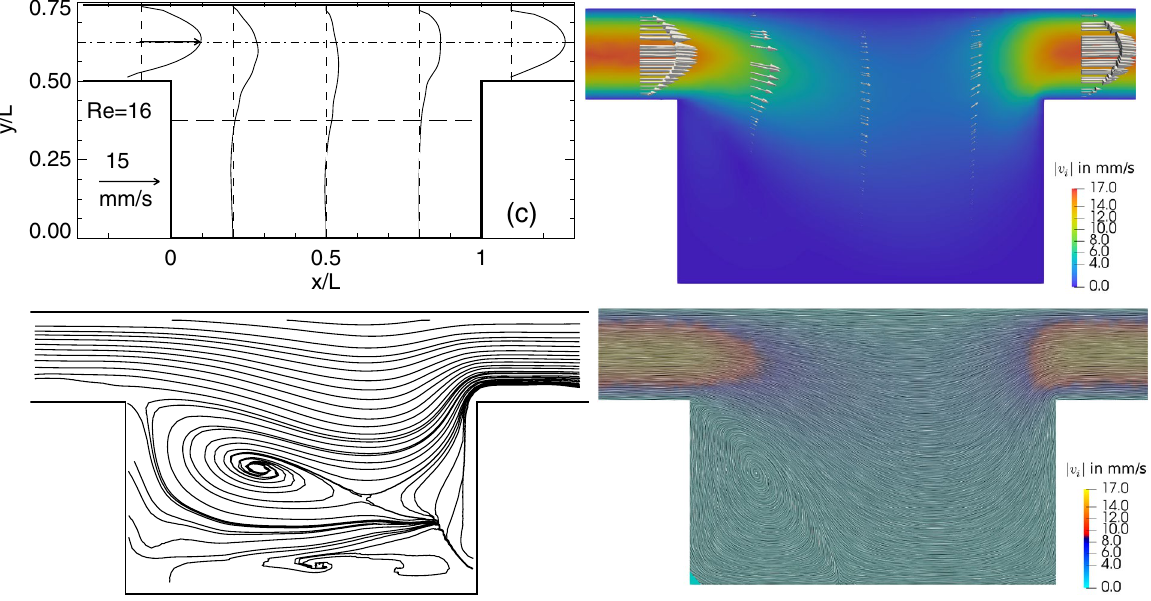
Fig. 8 Comparison of measurement and calculations: Case (c) PIV left column and CFD right column. Selected velocity profiles (top row) and streamlines (bottom row) are